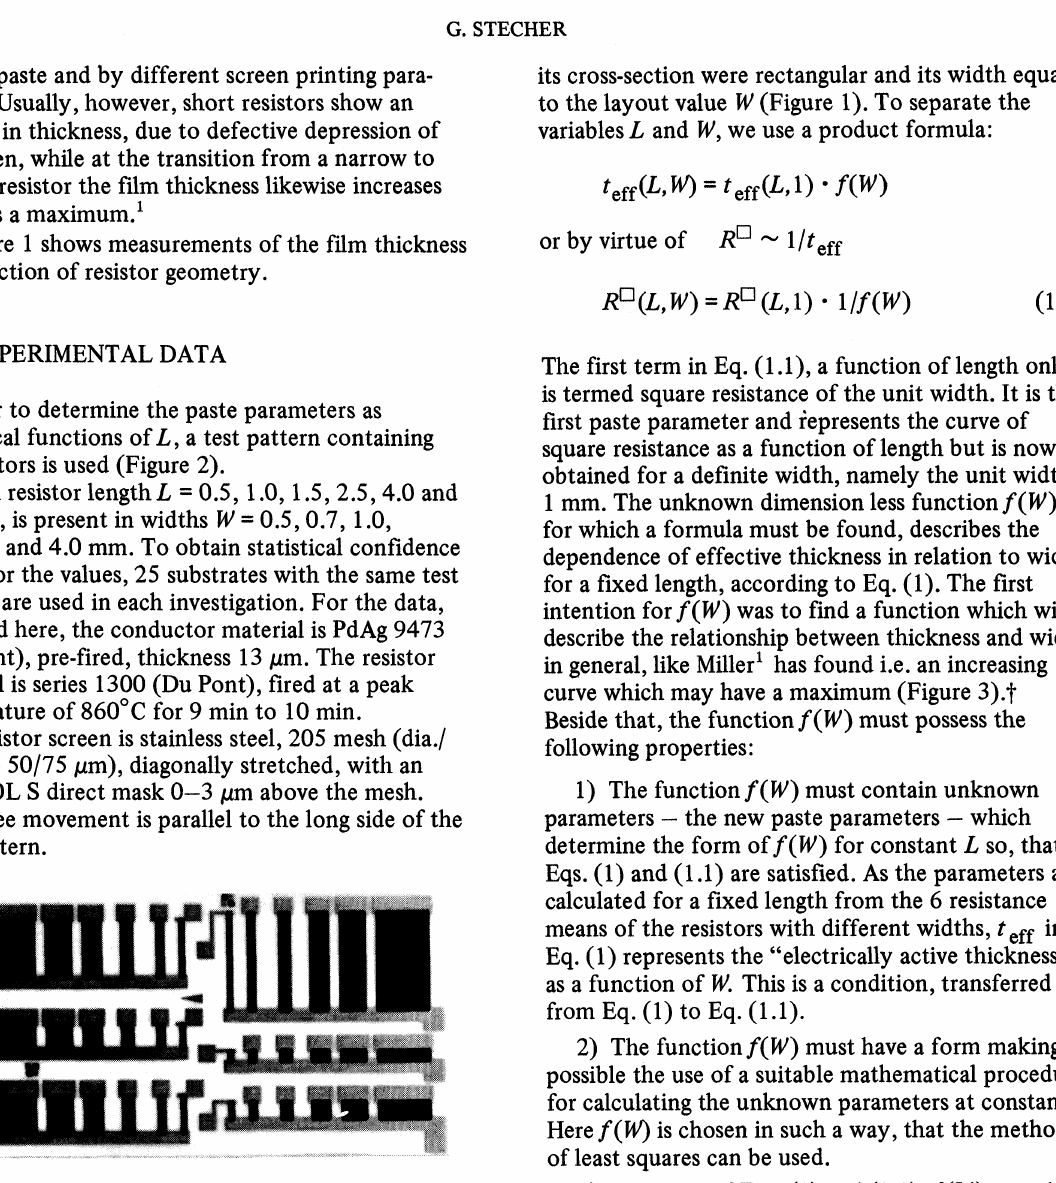
FIGURE 2 Resistor test pattern. Each resistor with a length L 0.5, 1, 1.5, 2.5, 4, 7 mm is present in widths W--- 0.5, 0.7, 1, 1.5, 2, 4